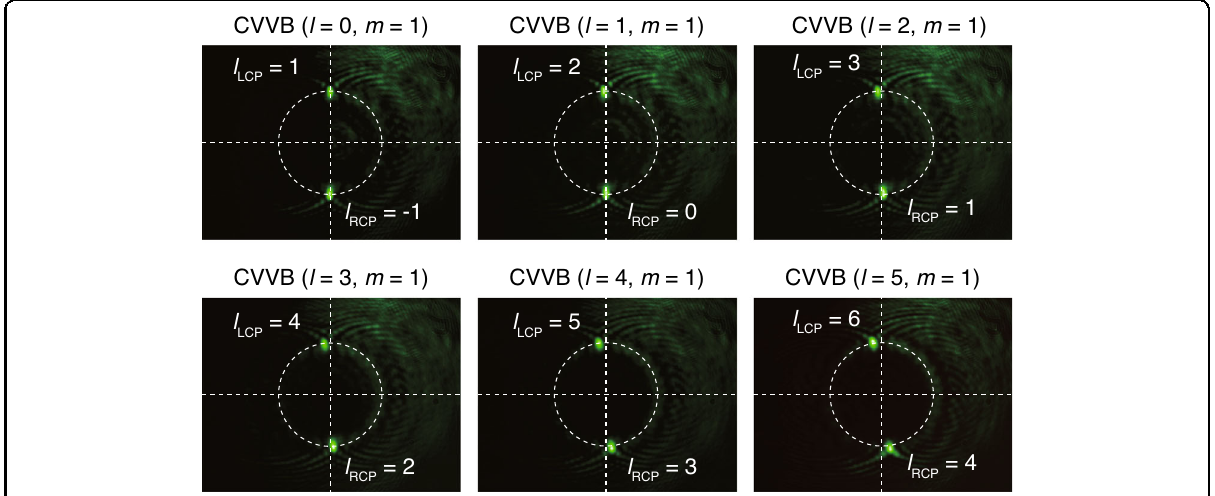
Fig. 5 Cylindrical vortex vector beam sorting at a wavelength of 532 nm. Measured focusing patterns for different phase singularities changing from 0 to 5 and polarization singularity m =